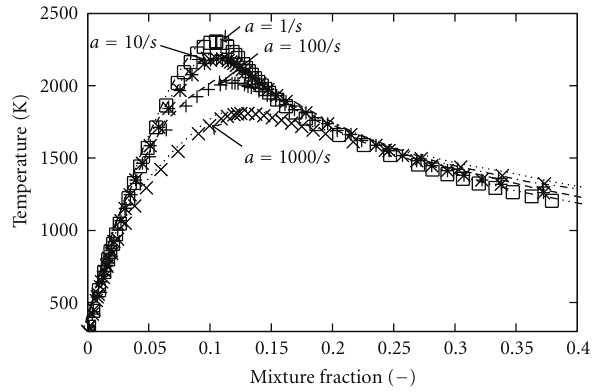
Figure 5: Comparison of computed H mass fractions versus mixture fraction for a Tsuji burner at strain rates a = 1 /s